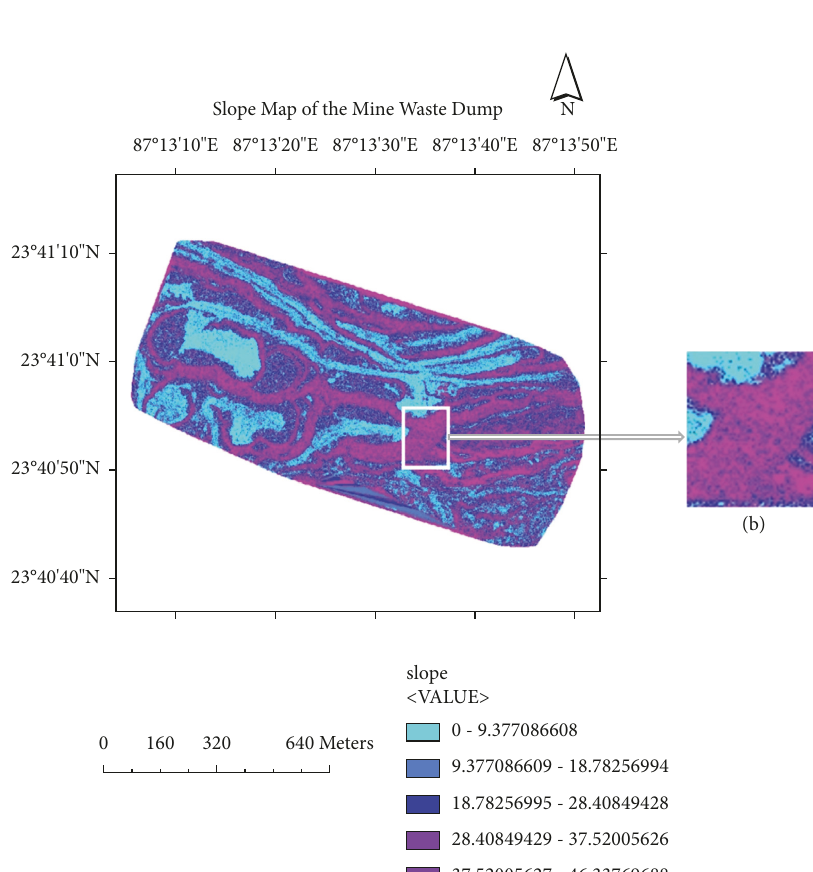
Figure 8: Slope map of the area and (b) cropped area represents the active waste dump